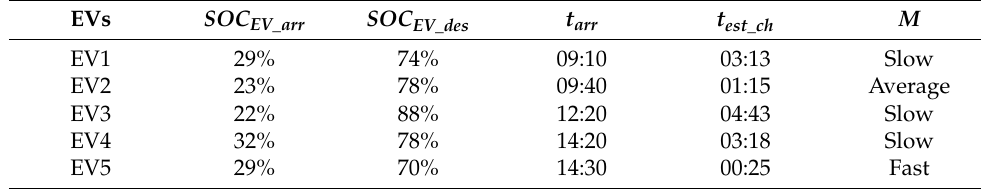
Table 2. Assumed options by the EV